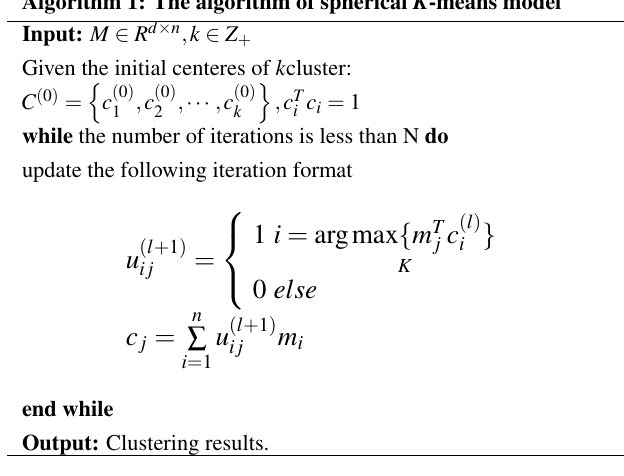
Figure 1. The algorithm of the spherical K -means